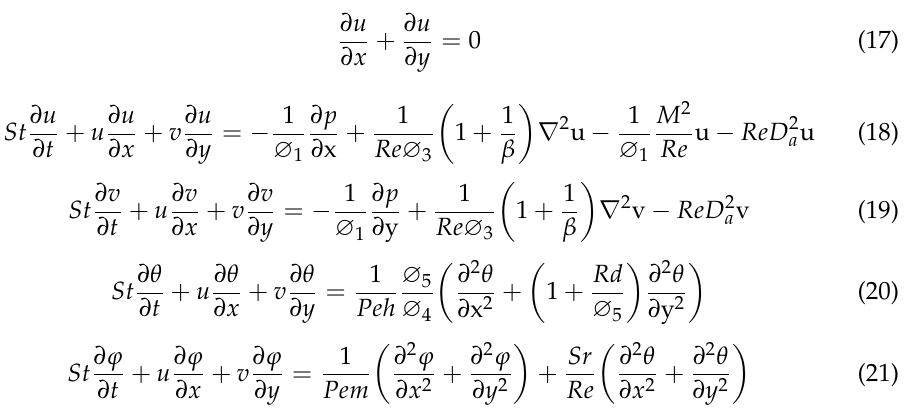
Table 1. Thermophysical properties of the base fluid water and the two kinds of NPs [38,39]. Physical Property Base Fluid Nanoparticles H 2 O Cu SWCNT C p (J/kgK) 4179 385 235 ρ (kg/m 3 ) 997.1 8933 10500 k (W/mK) 0.613 401 429 Equations (3), (5), (7), (8) and (10) after transformation become ∂